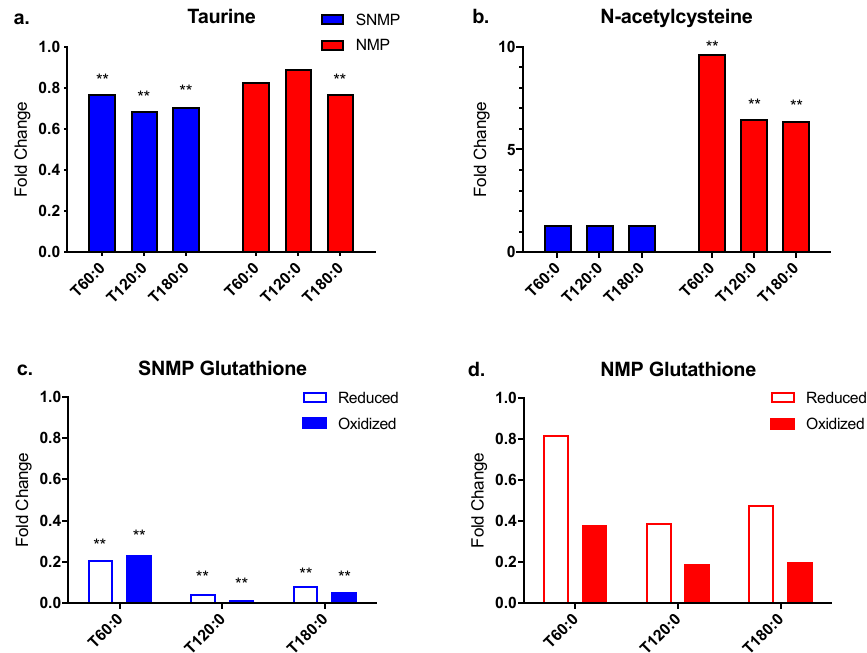
Figure 7. Oxidative stress metabolites during SNMP vs. NMP. ( a ) Taurine levels demonstrate a small but significant decrease during SNMP. ( b ) N-acetylcysteine levels are significantly increased during NMP. However, oxidized and reduced glutathione tissue concentrations are decreased in livers undergoing ( c ) SNMP and ( d ) NMP. Glutathione levels are significantly depleted during SNMP, but do not reach statistical significance during NMP. ** indicates p ≤ 0.05 and * indicates 0.05 < p < 0.10. Abbreviations: SNMP, subnormothermic machine perfusion; NMP, normothermic machine perfusion; x-axis represents fold change at 60, 120, and 180 min compared to pre-perfusion concentrations.